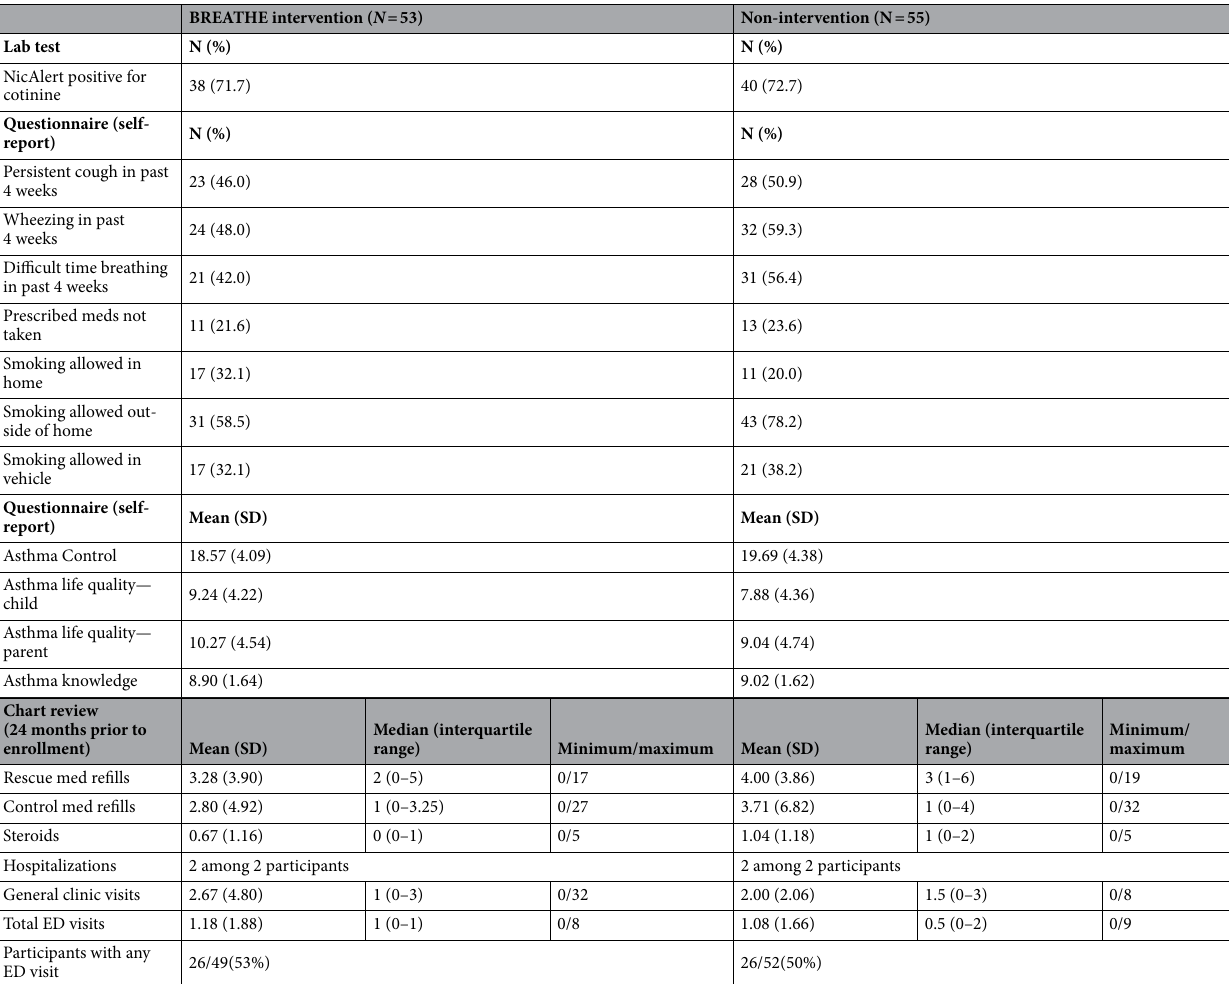
Table 2. Baseline outcomes of interest by group status.